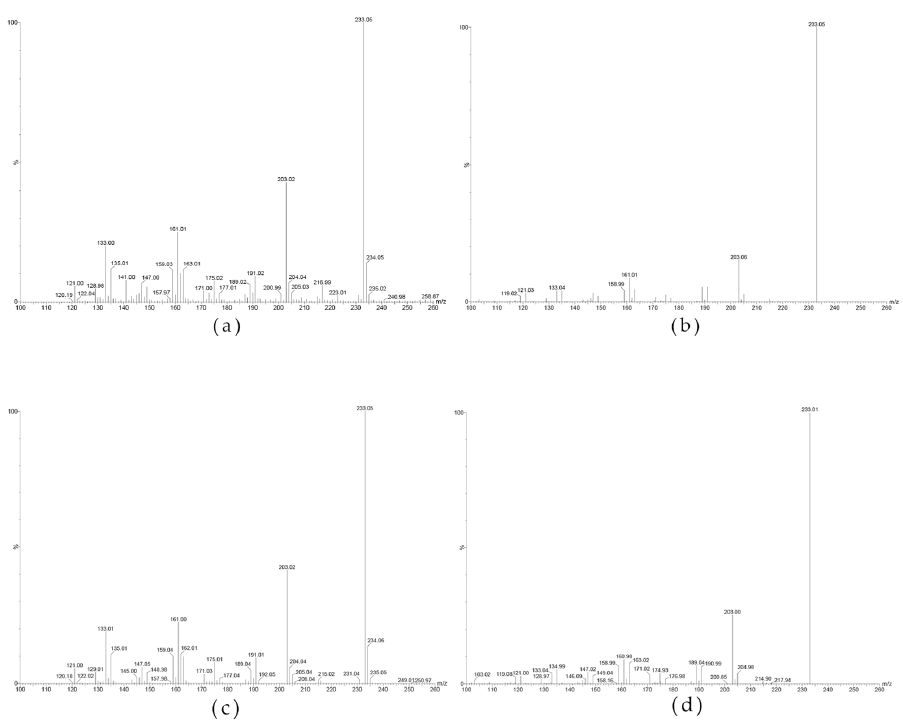
Figure 2. MS spectra ( a ) and MS 2 spectra ( b ) of AA ‐ API, MS spectra ( c ) and MS 2 spectra ( d ) of the visible foreign solids (main peaks).